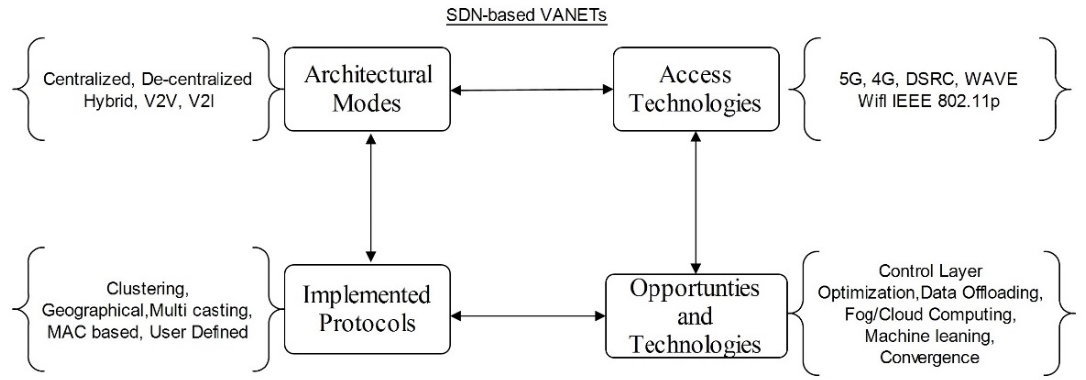
Figure 3. SDN architecture modes, technologies, and opportunities.